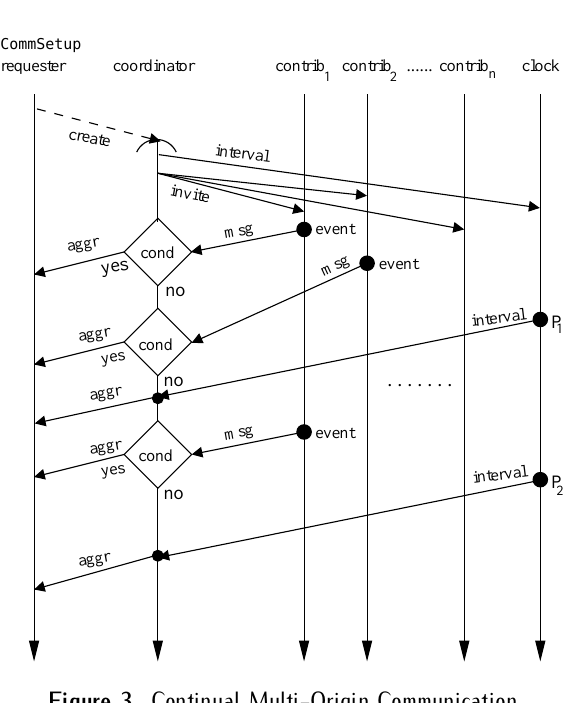
Figure 3. Continual Multi-Origin Communication